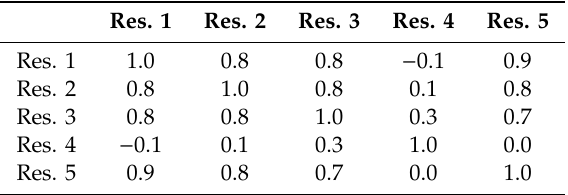
Table 3. The cross-correlation between inflows to reservoirs.